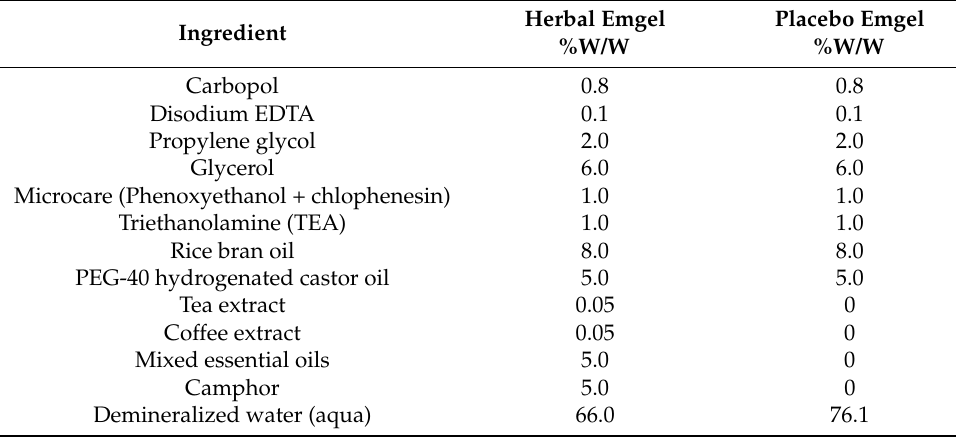
Table 6. Composition of the emgels used to treat